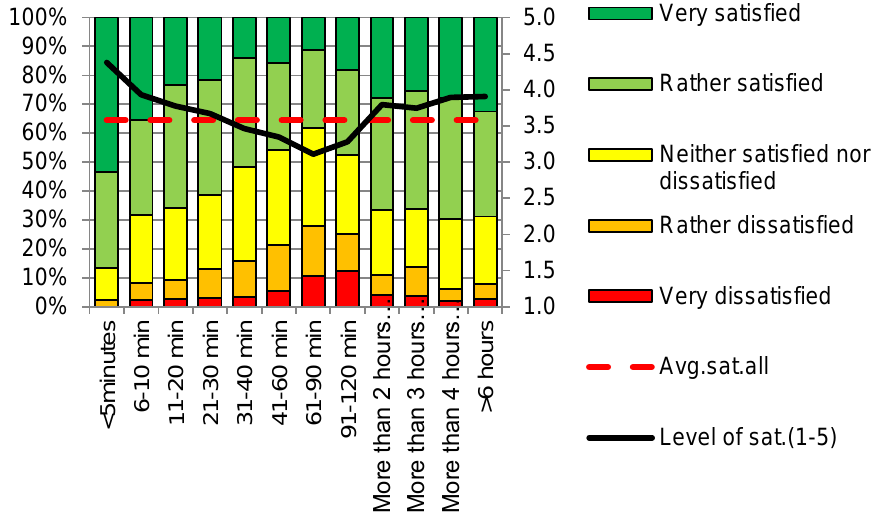
Figure 4. Overall travel satisfaction by trip duration